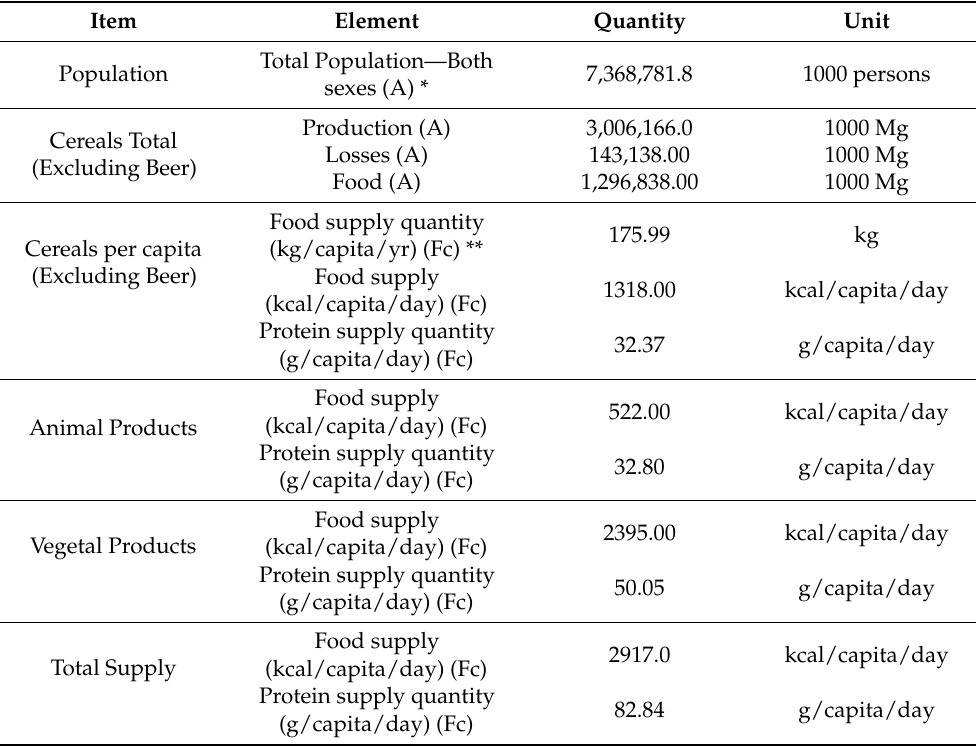
Table 2. Cereals produced, lost and consumed in 2017. Data source: FAOSTAT [39], edited by